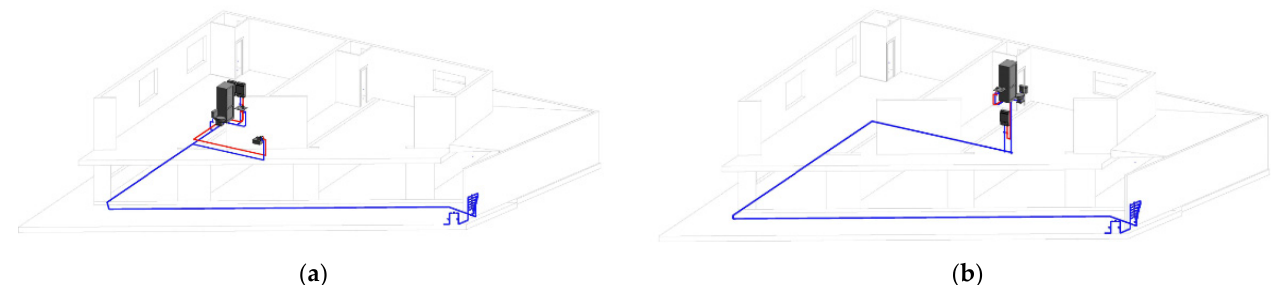
Figure 10. Sanitary plumbing water systems for the retail stores under study: ( a ) type 1 (first floor); ( b ) type 2 (second floor).